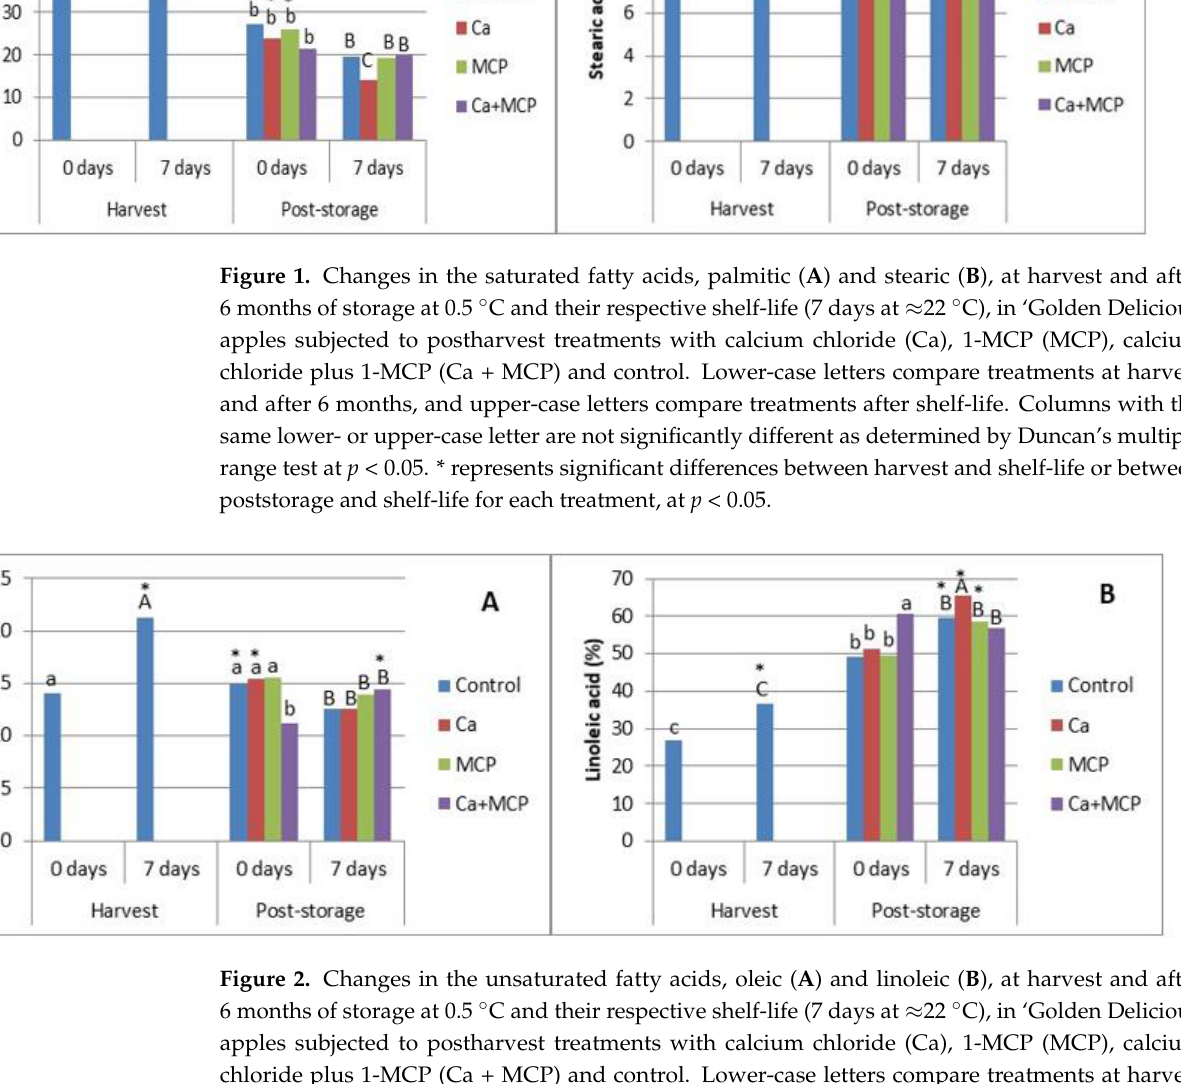
Figure 1. Changes in the saturated fatty acids, palmitic ( A ) and stearic ( B ), at harvest and after 6 months of storage at 0.5 °C and their respective shelf-life (7 days at ≈22 ° C), in ‘Golden Delicious’ apples subjected to postharvest treatments with calcium chloride (Ca), 1-MCP (MCP), calcium chlo- ride plus 1-MCP (Ca+MCP) and control. Lower-case letters compare treatments at harvest and